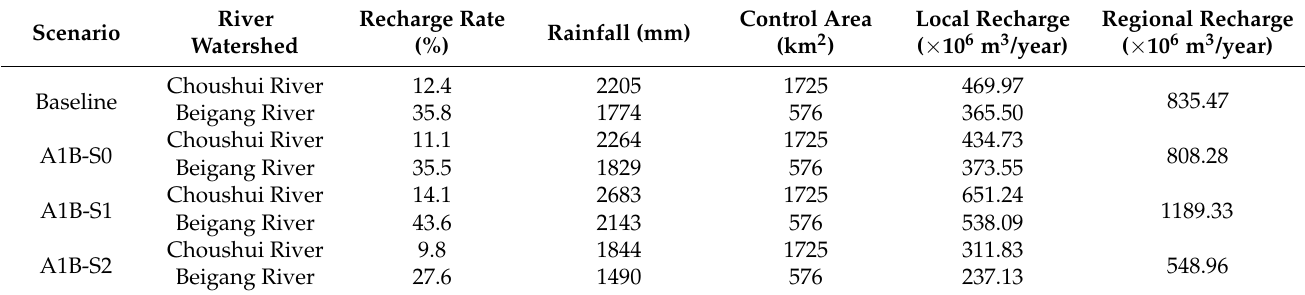
Table 8. Groundwater recharge calculation in the Choushui River alluvial fan under various climate scenarios.